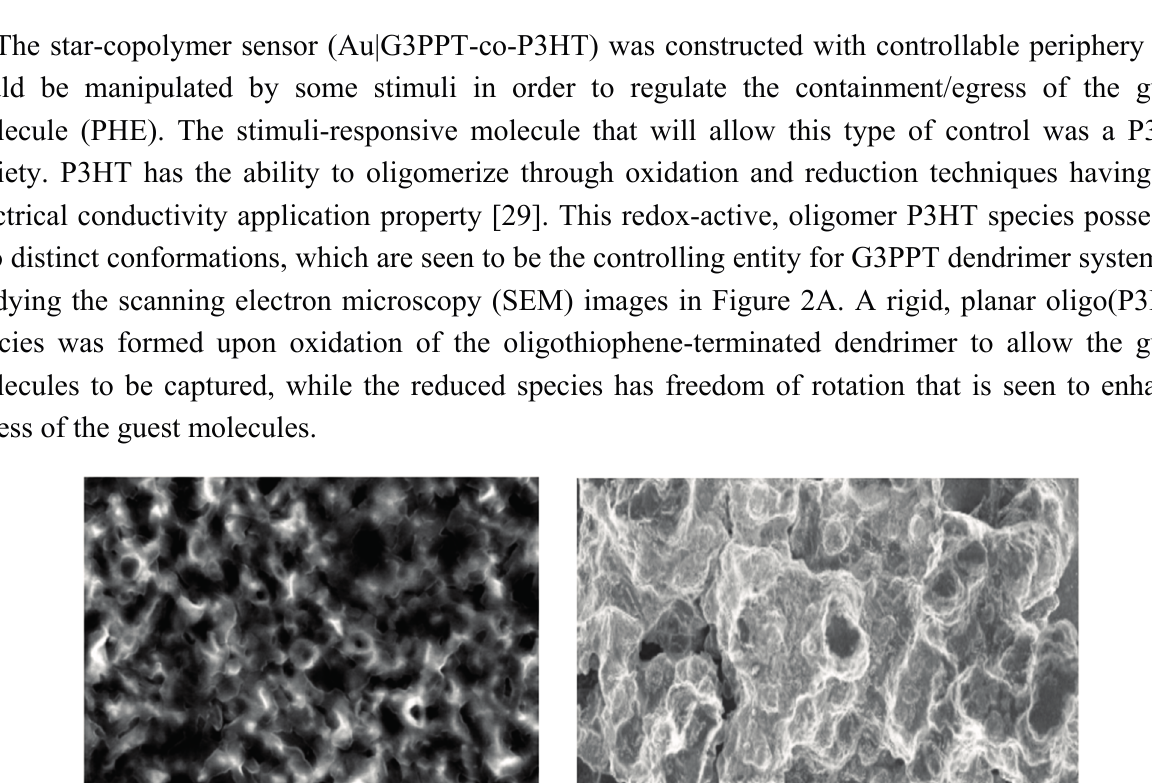
Figure 1. 1 HNMR and FTIR spectrum of generation 3 poly(propylene thiophenoimine) (G3PPT).